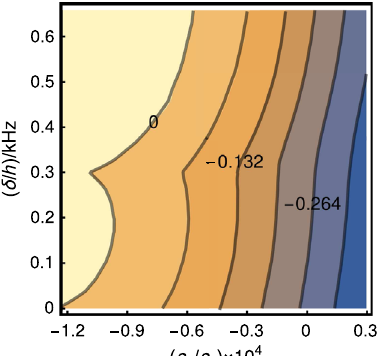
FIG. 3. The contours show the negative of the three-boson binding energy, in kHz, of the lowest state in the second-lowest Þ − 1 and ˜ δ for k = κ (cid:3) ≈ 1 . 32 and manifold as functions of ð a s so Ω ¼ 2 E , where κ (cid:3) denotes the binding momentum of the first so excited Efimov trimer at unitarity in the absence of spin-orbit coupling. The conversion to a 0 and kHz is done using the experimentally determined value of a ð 1 Þ − for Cs (see text). ˆ ¯ ¼ V H The calculations are performed for with V 2 2 b ; G rel b